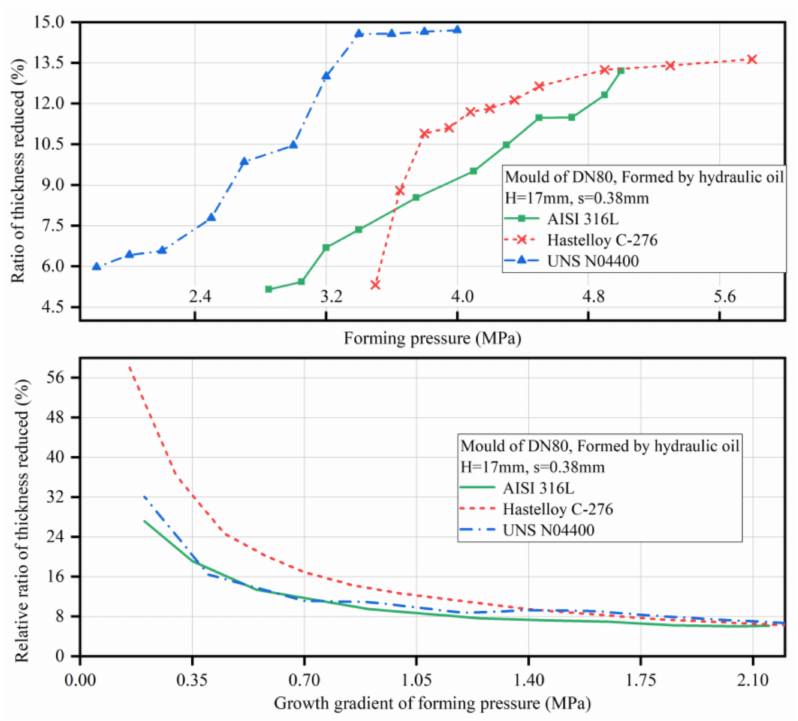
Figure 20. Absolute and relative ratios of thickness reduction for Dn 80 mm rupture discs with different